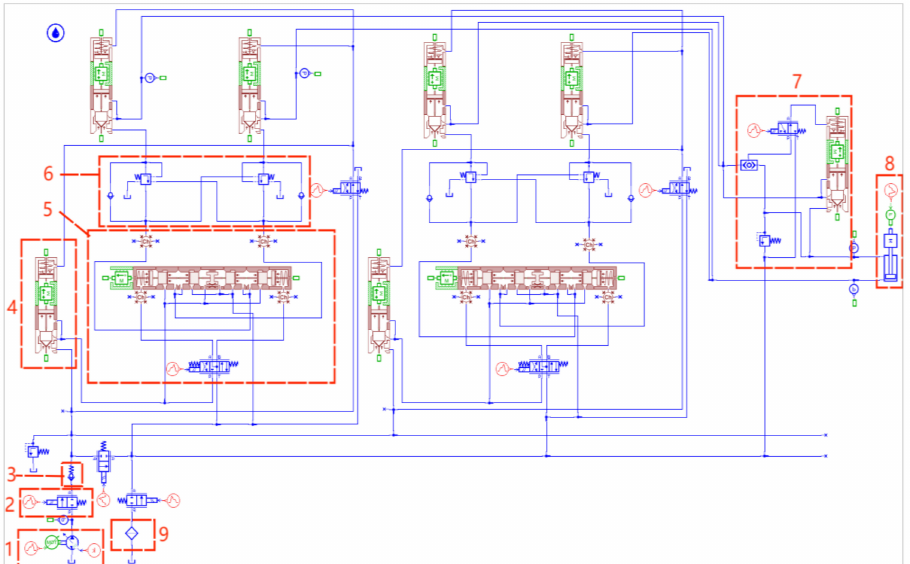
Figure 3. Simulation model of the wing lifting and lowering hydraulic system. 1. Hydraulic pump; 2. globe valve; 3. check valve; 4. cartridge valve; 5. electro-hydraulic re-versing valve; 6. balance valve group; 7. safety globe valve group; 8. hydraulic cylinder; 9. oil return filter.